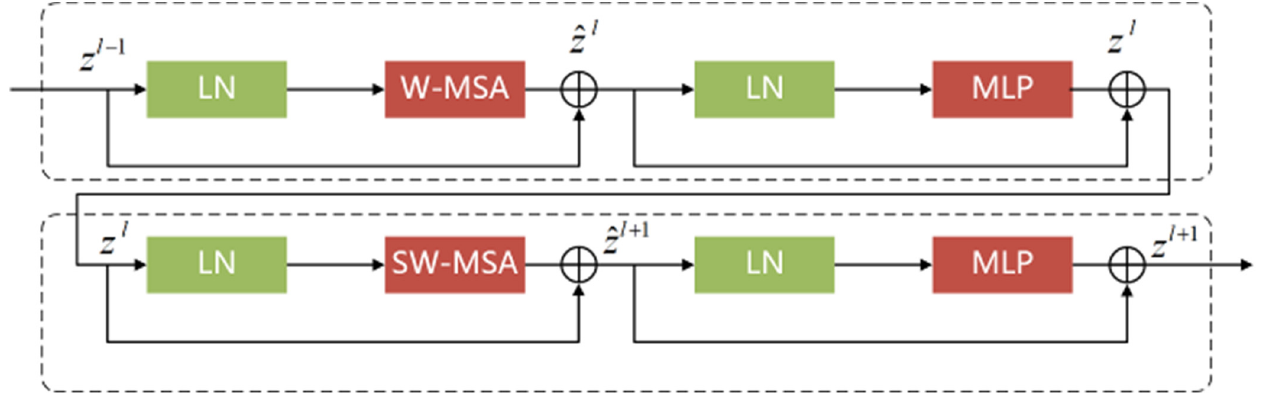
Figure 2. The illustration of two successive Swin Transformer blocks. W-MSA and SW-MSA are window-based self-attention modules which are based on regular or shifted windowing configurations, respectively.